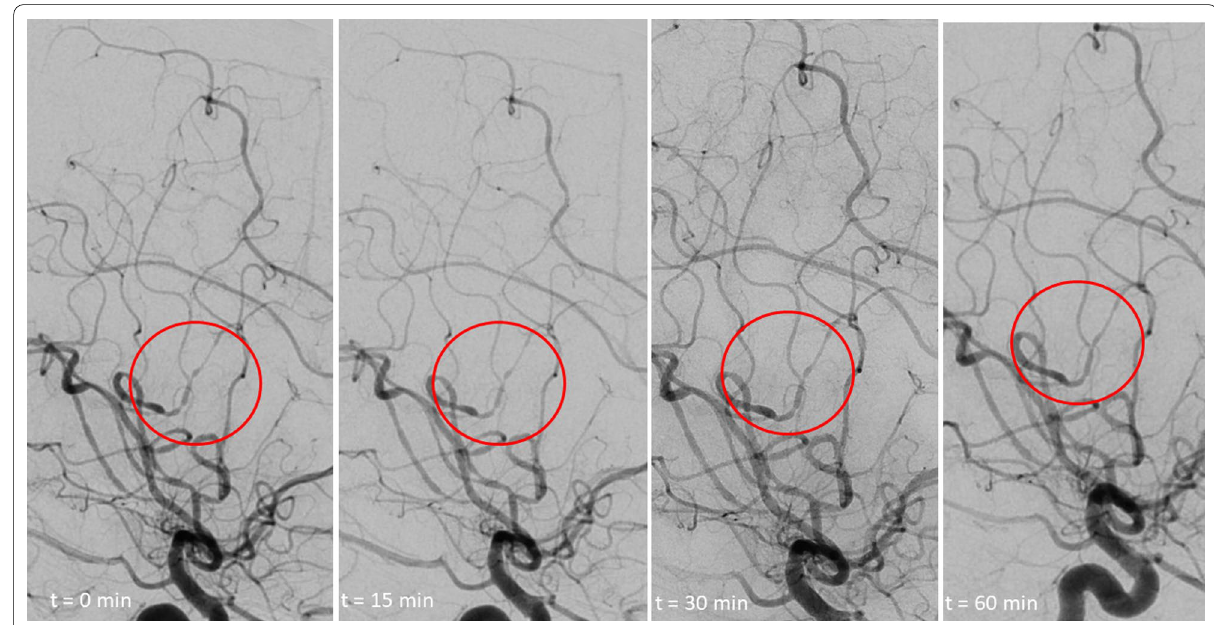
Fig. 2 Angiogram showing delayed reversibility of intracranial stenoses after